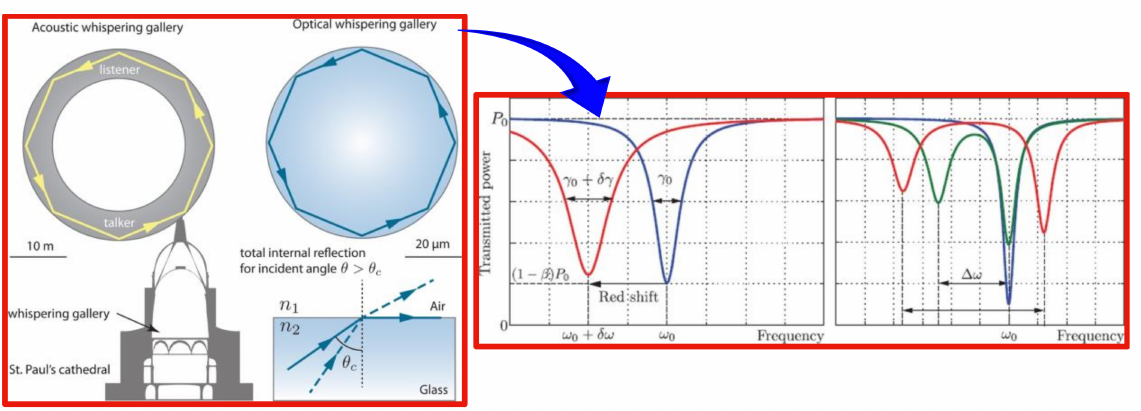
Figure 9. Whispering gallery modes-based sensors. Adapted with permission from [196] Copyright 2015 © The Optical